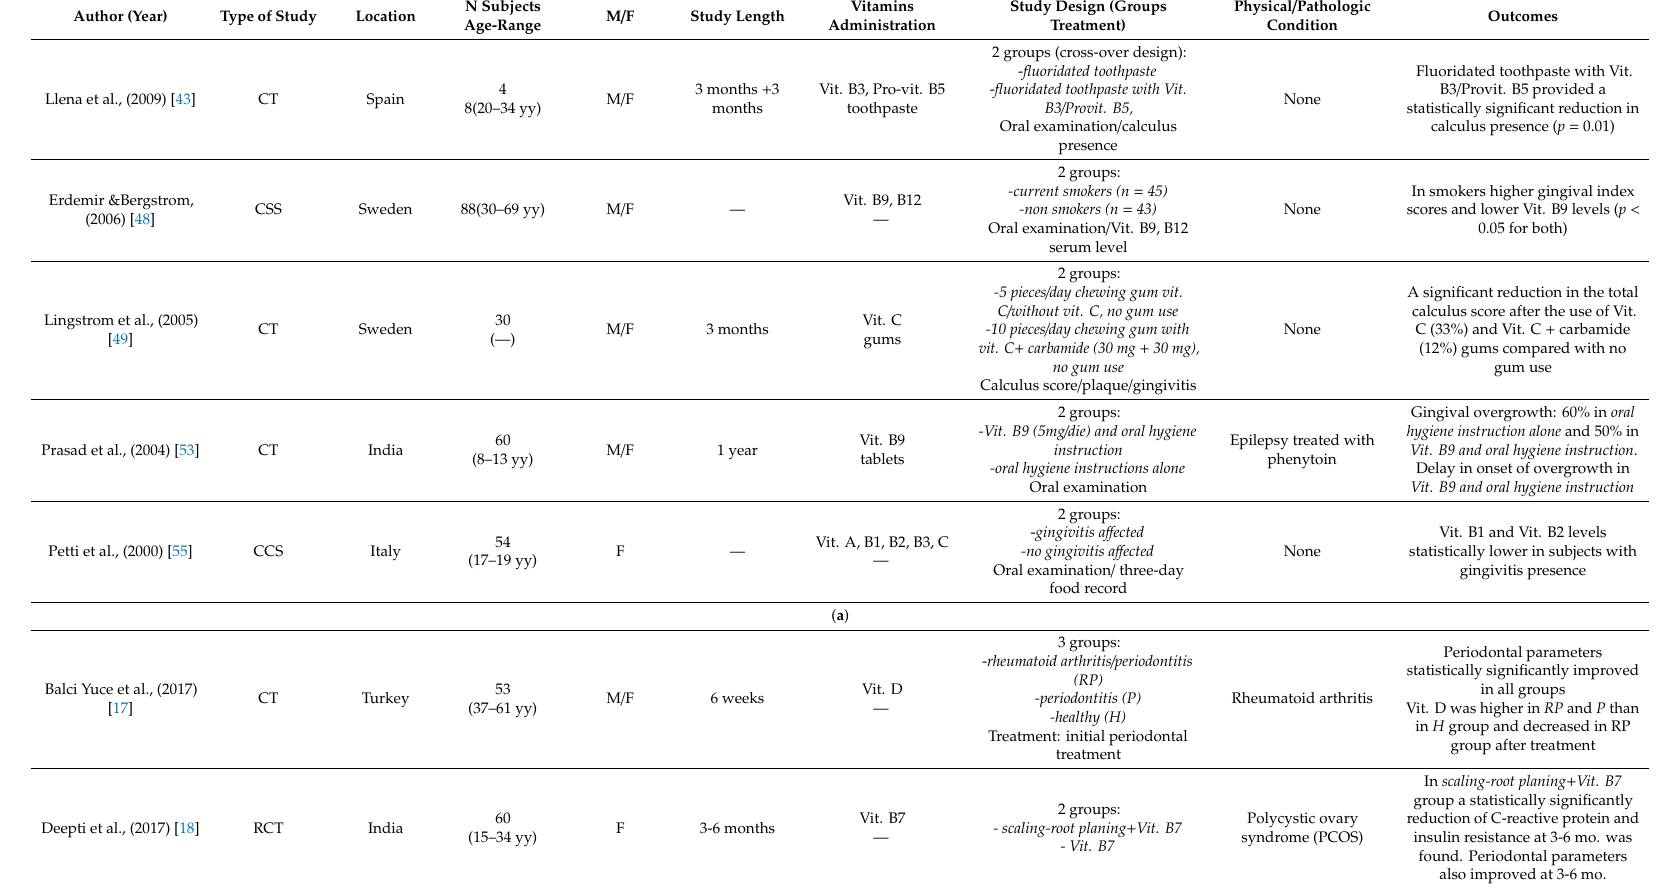
Fluoridated toothpaste with Vit. B3 / Provit. B5 provided a None statistically significant reduction in calculus presence ( p = 0.01) In smokers higher gingival index None scores and lower Vit. B9 levels ( p < 0.05 for both) A significant reduction in the total calculus score after the use of Vit. None C (33%) and Vit. C + carbamide (12%) gums compared with no gum use Gingival overgrowth: 60% in oral hygiene instruction alone and 50% in Epilepsy treated with Vit. B9 and oral hygiene instruction . phenytoin Delay in onset of overgrowth in Vit. B9 and oral hygiene instruction Vit. B1 and Vit. B2 levels None statistically lower in subjects with gingivitis presence Periodontal parameters statistically significantly improved in all groups Rheumatoid arthritis Vit. D was higher in RP and P than in H group and decreased in RP group after treatment In scaling-root planing + Vit. B7 group a statistically significantly Polycystic ovary reduction of C-reactive protein and insulin resistance at 3-6 mo. was syndrome (PCOS) found. Periodontal parameters also improved at 3-6